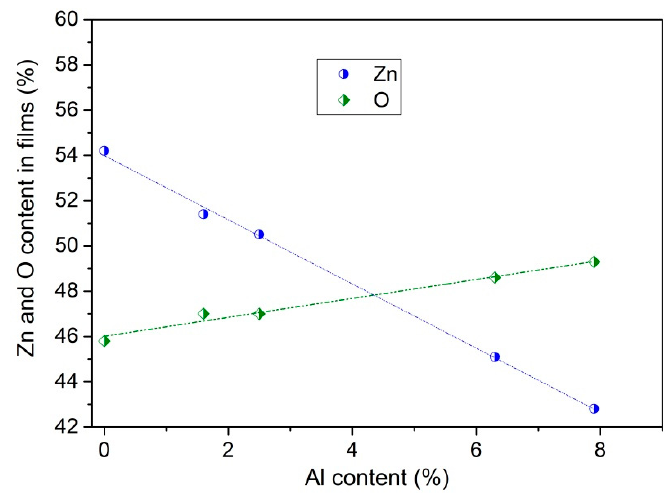
Figure 5. Relation between chemical composition of ZnO and AZO films on Al atomic